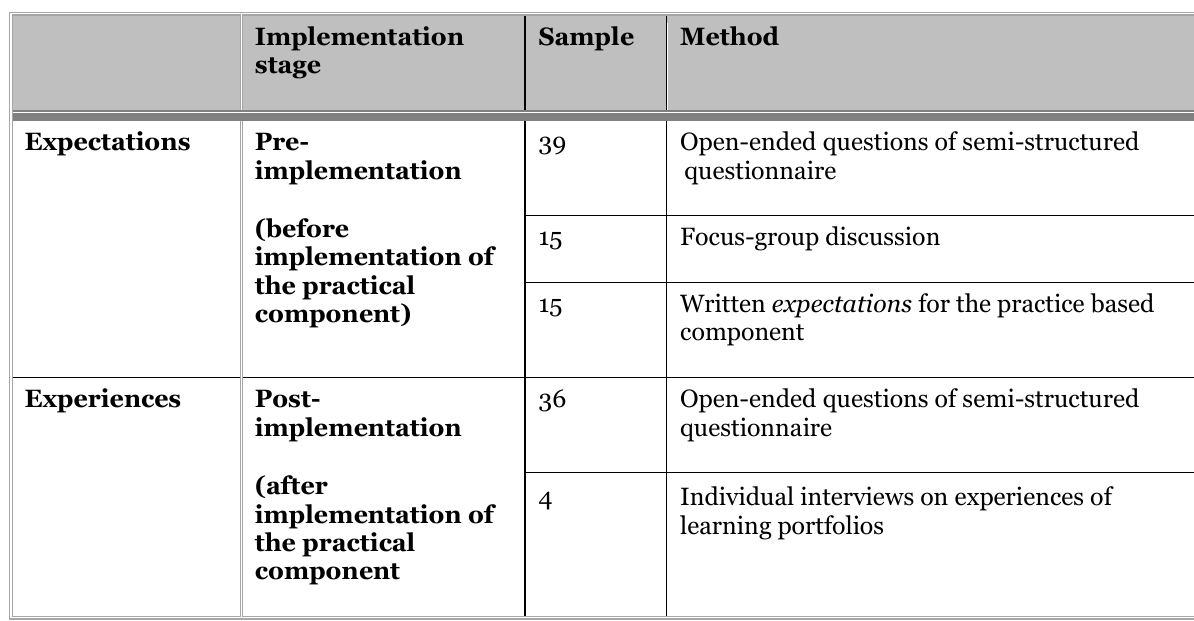
Table 1 Data Collecting: Samples, Methods, and